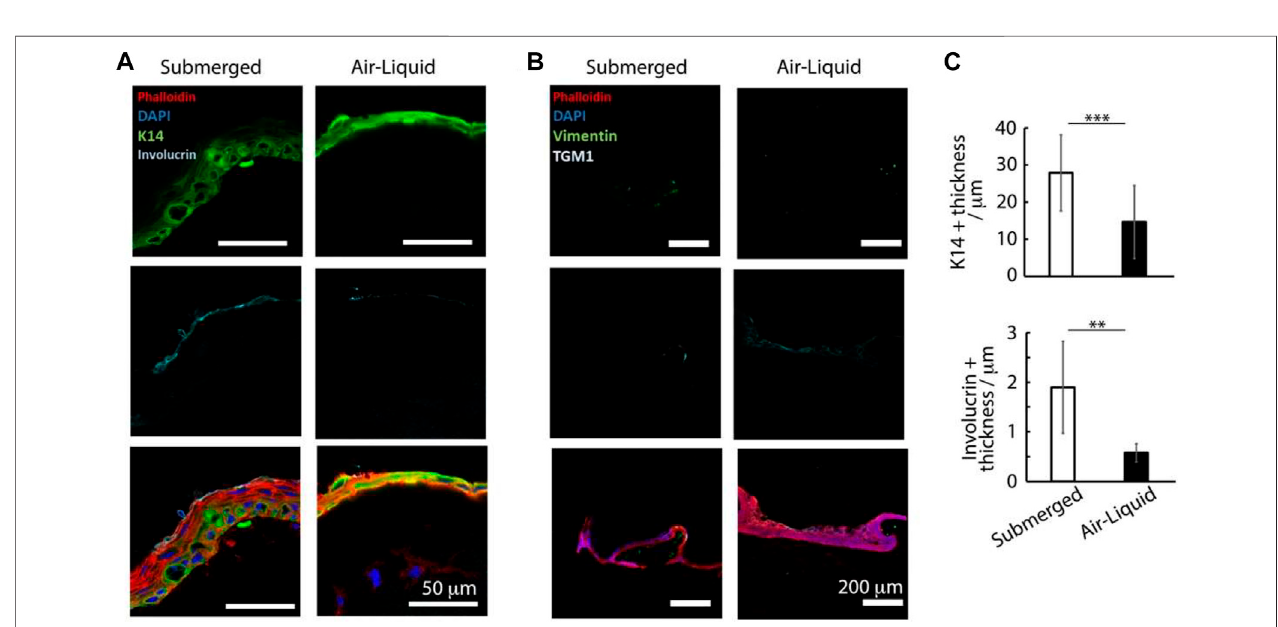
FIGURE 4 | Histology sections ofavascular skin-on-chip constructs immuno-stained with phalloidin (red), DAPI (blue), and for K14 and involucrin (green and cyan, respectively); (A) for vimentin and transglutaminase green and cyan, respectively. (B) After an initial culture of 7 days, tissues were further cultured for 7 days in submerged or air-liquid conditions. (C) Quanti fi cation of the corresponding density of K14+ tissue thickness and involucrin-positive tissue thickness. ** p < 0.01; *** p < 0.001; n.s., non-signi fi cant, p > 0.05; error bars are standard errors; n = 3.